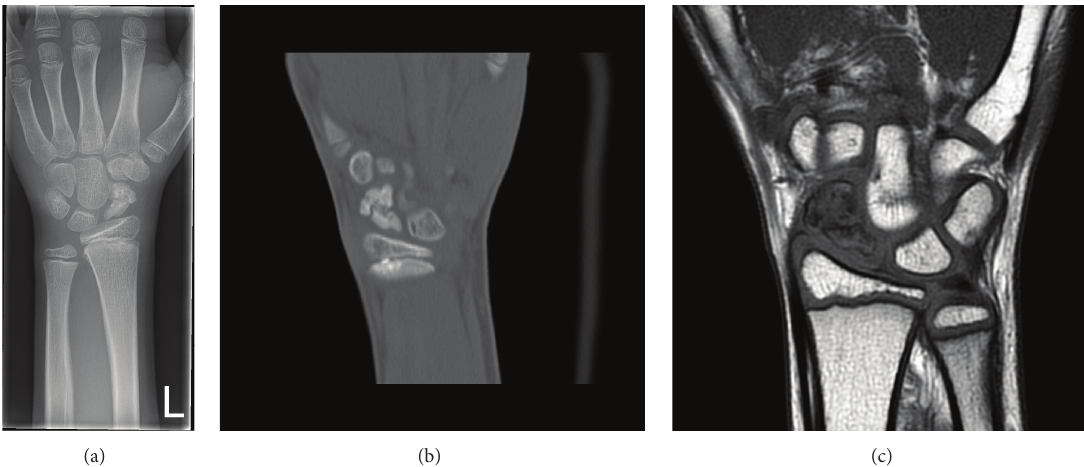
Figure 1: (a) Plain radiograph at acute presentation showing a fracture of the scaphoid waist with sclerosis, central cystic bone alteration, and deformity of the proximal pole. (b) CT scan 1 week after the initial injury showing a more pronounced central cystic bone alteration and irregularity of the fracture border. (c) MRI T1 showing signal loss of the whole scaphoid.